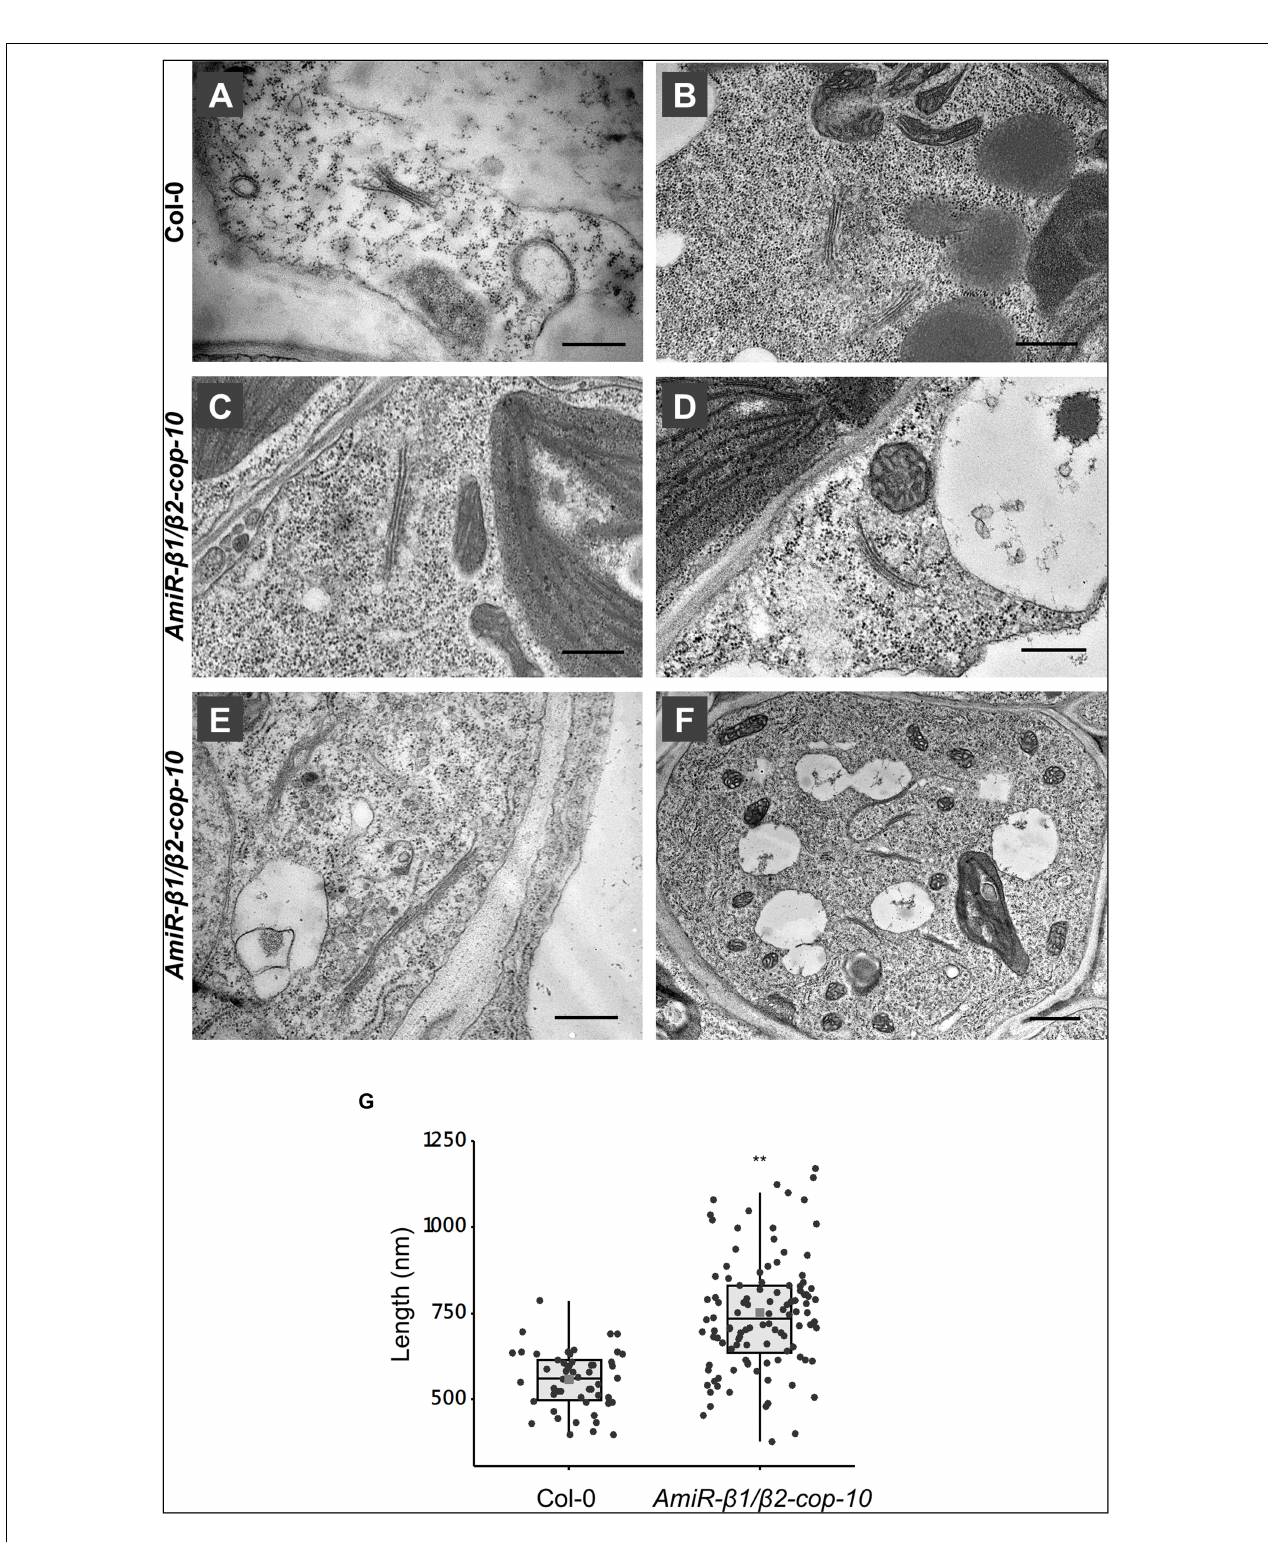
FIGURE 7 | Ultrastructural analysis of the amiR- β 1/ β 2-cop mutant. Chemically fixed cotyledon cells from 4-day-old seedlings of wild type (Col-0) (A,B) and the amiR- β 1/ β 2-cop mutant (C–F) . Scale bars: (A–E) – 500 nm; (F) – 1 mm. (G) Quantification of the length of the Golgi apparatus in wild-type (Col-0) cells and in the amiR- β 1/ β 2-cop mutant. n = 52 (Col-0) and 111 ( amiR- β 1/ β 2-cop ). Golgi length was higher in the amiR- β 1/ β 2-cop mutant compared with wild-type (Col-0). Statistical significance: ** p < 0.01.